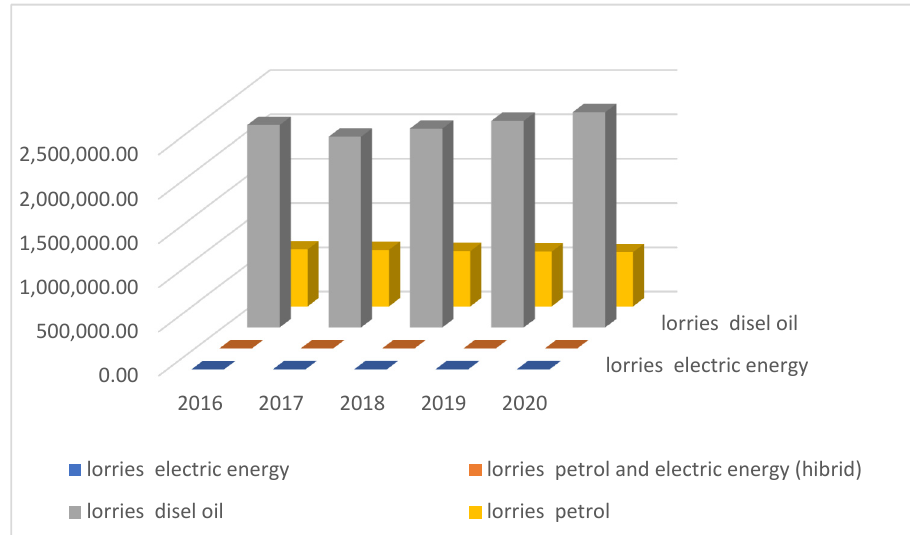
Figure 3. Breakdown of vehicles by fuel used in Poland [58–61]. According to Gajewski J., Paprocki W., and Pieriegud J. [7], the electrification of the